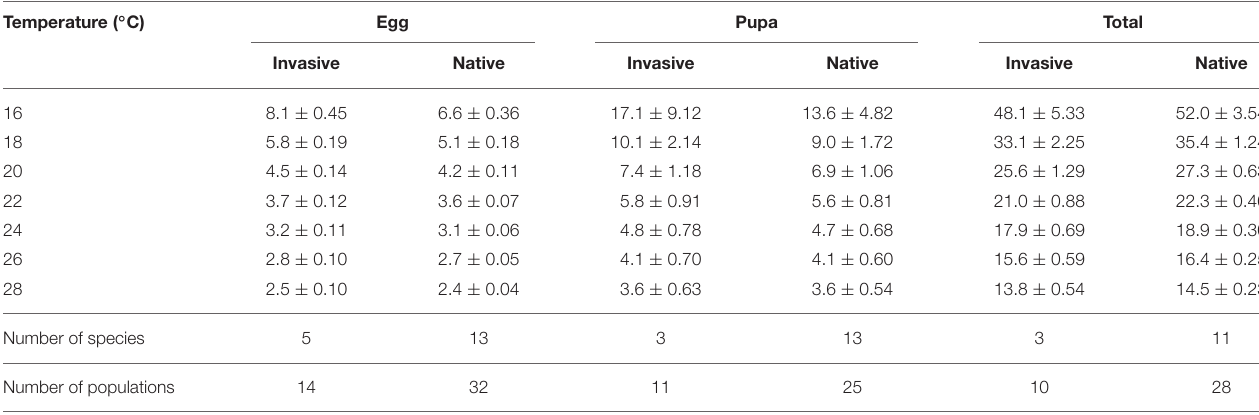
TABLE 5 | The duration of egg, pupa and total development (measured in days) at seven constant temperatures in species invasive to the Nearctic ( C. septempunctata, C. undecimpunctata, H. axyridis, H. variegata, P. quatuordecimpunctata ), and native to the Nearctic ( A. bipunctata, Calvia quatuordecimguttata, Cheilomenes sulphurea, C. californica, C. novemnotata, C. transversoguttata, C. trifasciata, C. maculata, Cycloneda polita, H. parenthesis, H. convergens, H. quinquesignata, H. sinuata, Lemnia biplagiata, O. v-nigrum ).